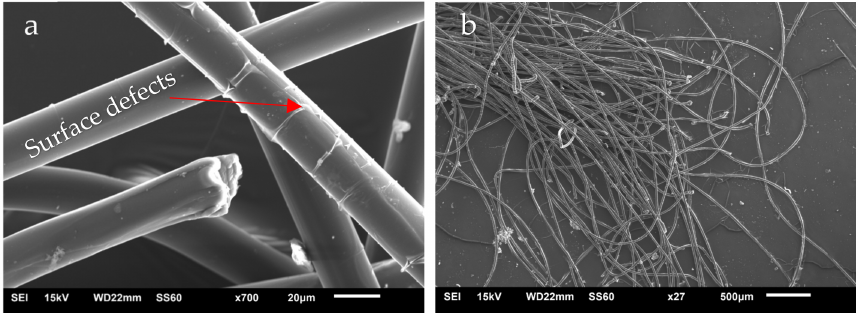
Figure 4. PET Fiber SEM with magnification of: ( a ) 700 × ; ( b ) 27 ×